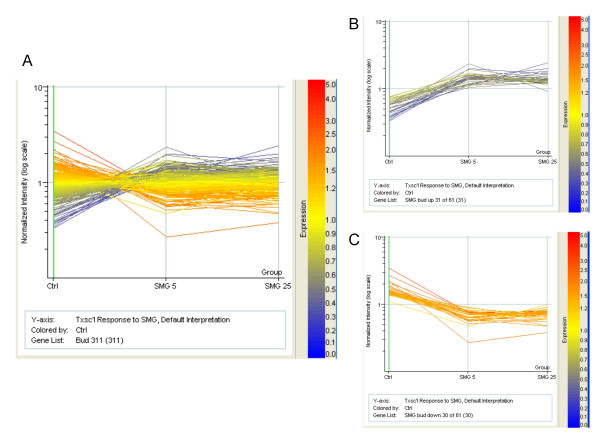
A. A comparison of the low-shear modeled microgravity response (SMG) with 311 MIPS functional category (43.01.03.05) genes involved in budding and cell polarity functions. B. The 31genes from the list of 311 that are up-regulated greater than 2-fold compared to controls. C. The 30 genes from the list of 311 that are down-regulated greater than 2-fold compared to controls. Expression levels are indicated on the color scale bars.